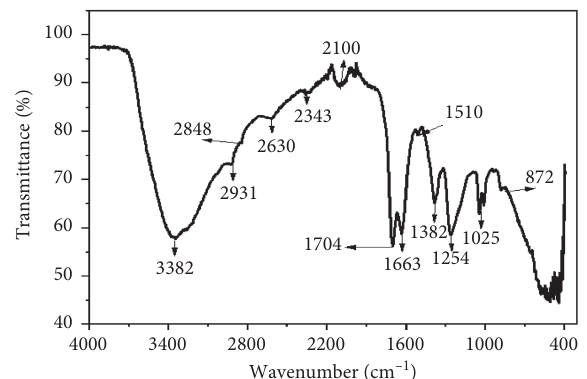
Figure 5: Characterization results of the intermediate product using